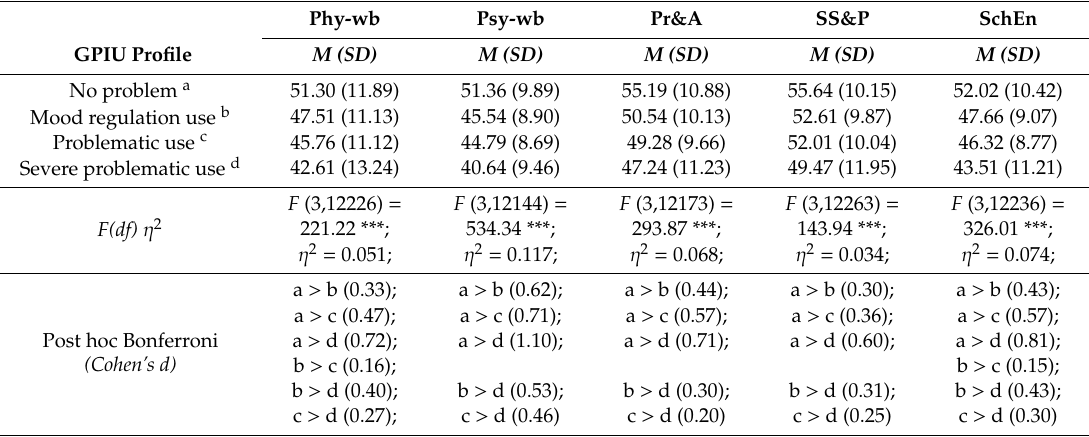
Table 6. Di ff erences in the KIDSCREEN-27 dimensions as a function of the internet use profile